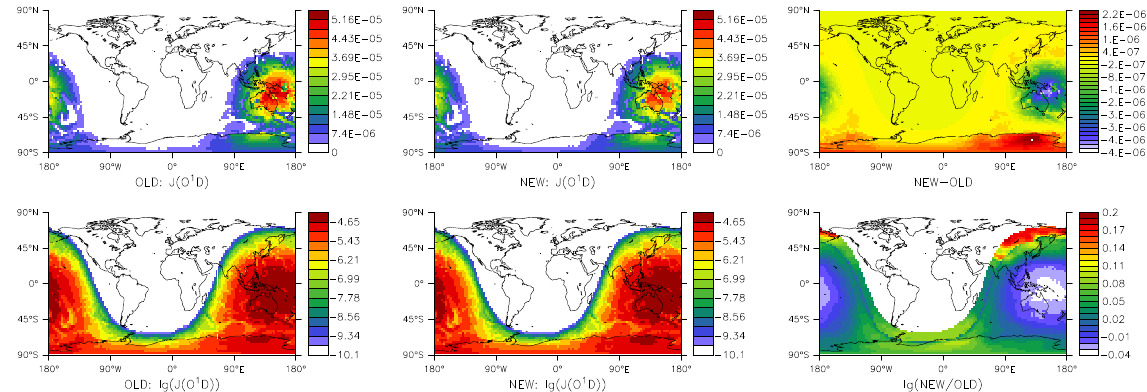
Figure 2. Comparison of old and new J values (in s − 1 ) for O 3 → O( 1 D) , calculated for 2000-01-01, 02:00 UTC at the surface. The first row is plotted on a linear scale, the second on a logarithmic scale. The left column shows the old result, the center column the new result, and the right column the differences.